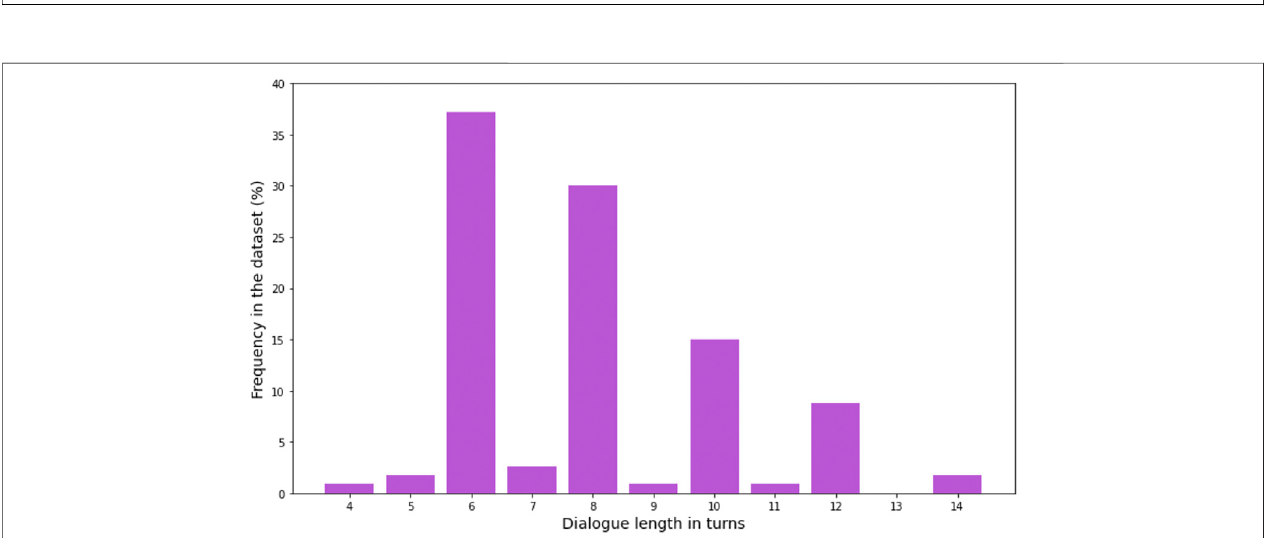
FIGURE 7 | An example dialogue annotated with dialogue acts in Doccano.